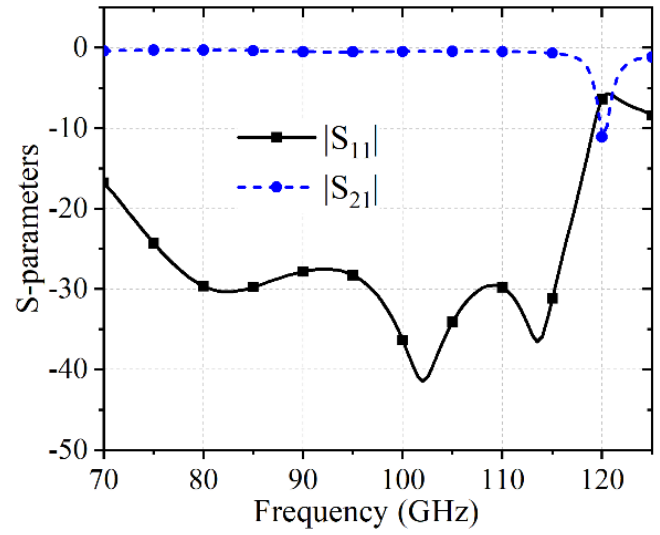
Figure 3. The configuration of the proposed transition. ( a ) 3D view. ( b ) Top view.